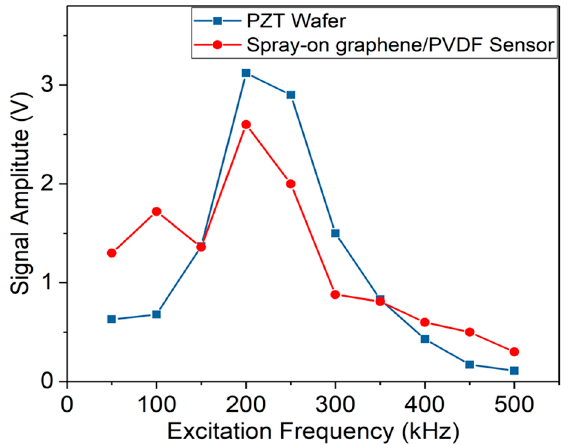
Figure 5. GUW signal amplitude (S 0 mode) of spray-on graphene/PVP sensor and PZT wafer under excitation frequencies of 50-500 kHz.